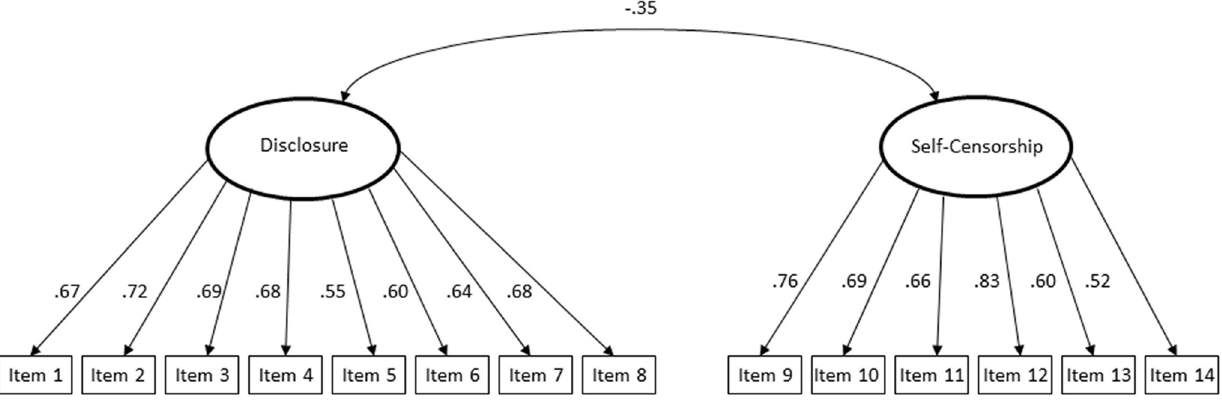
Figure 1. Confirmatory factor analysis of the self-censorship orientation scale: A two-factor solution. Note . Coefficients correspond to the arrow on their right and item numbers correspond to Table 1. All coefficients were significant ( p <